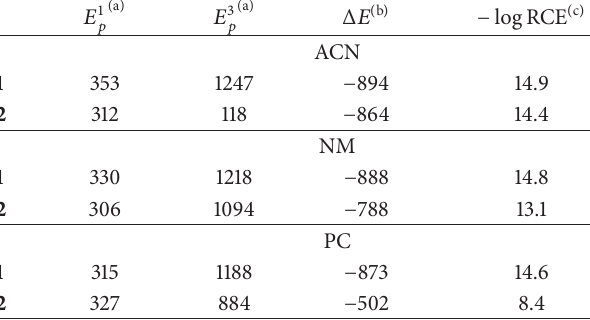
Table 2: Potentials of first oxidation peak, 𝐸 1 𝑝 , and complex oxid- ation peak 𝐸 3 𝑝 , Δ𝐸 , and the logarithm of the reaction coupling effi- ciency (log RCE) for compounds 1 and 2 in the presence of 0.5 equivalent of Cd 2+ in ACN, NM, PC, and DMF containing 0.1M TBABF 4